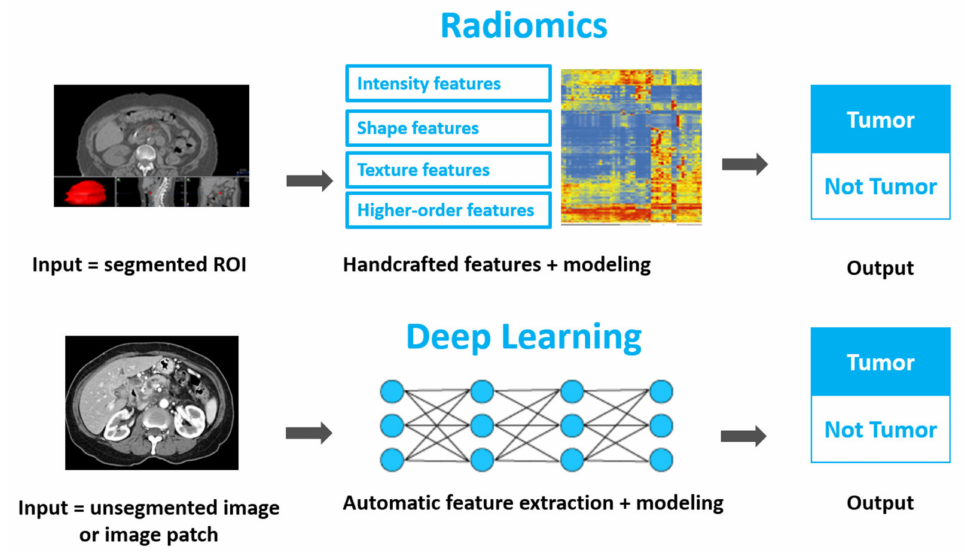
Figure 1. A schematic drawing comparing the radiomics approach and the deep learning approach, using an example case of tumor